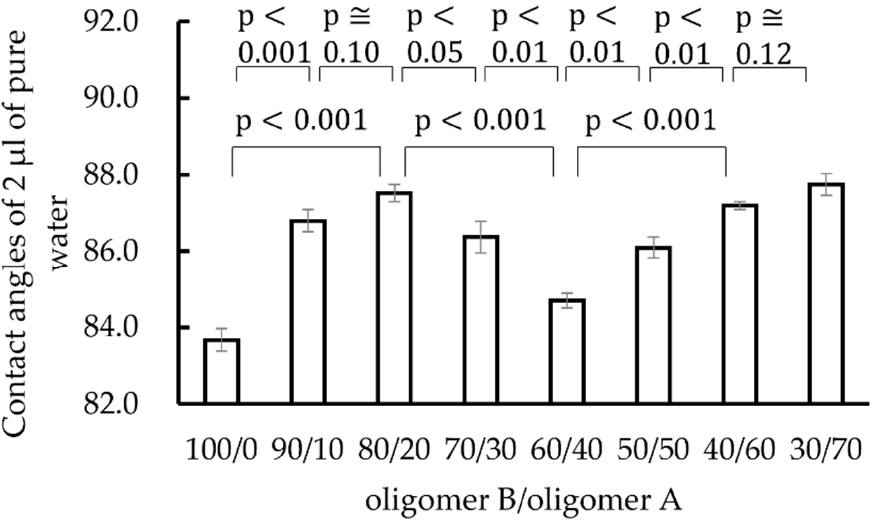
Figure 5. Contact angles of 2 µL of pure water droplets on polysiloxane films with various compo- sitions of oligomer B/oligomer A ranging from 100/0 to 30/70. The standard error is shown as an error bar.